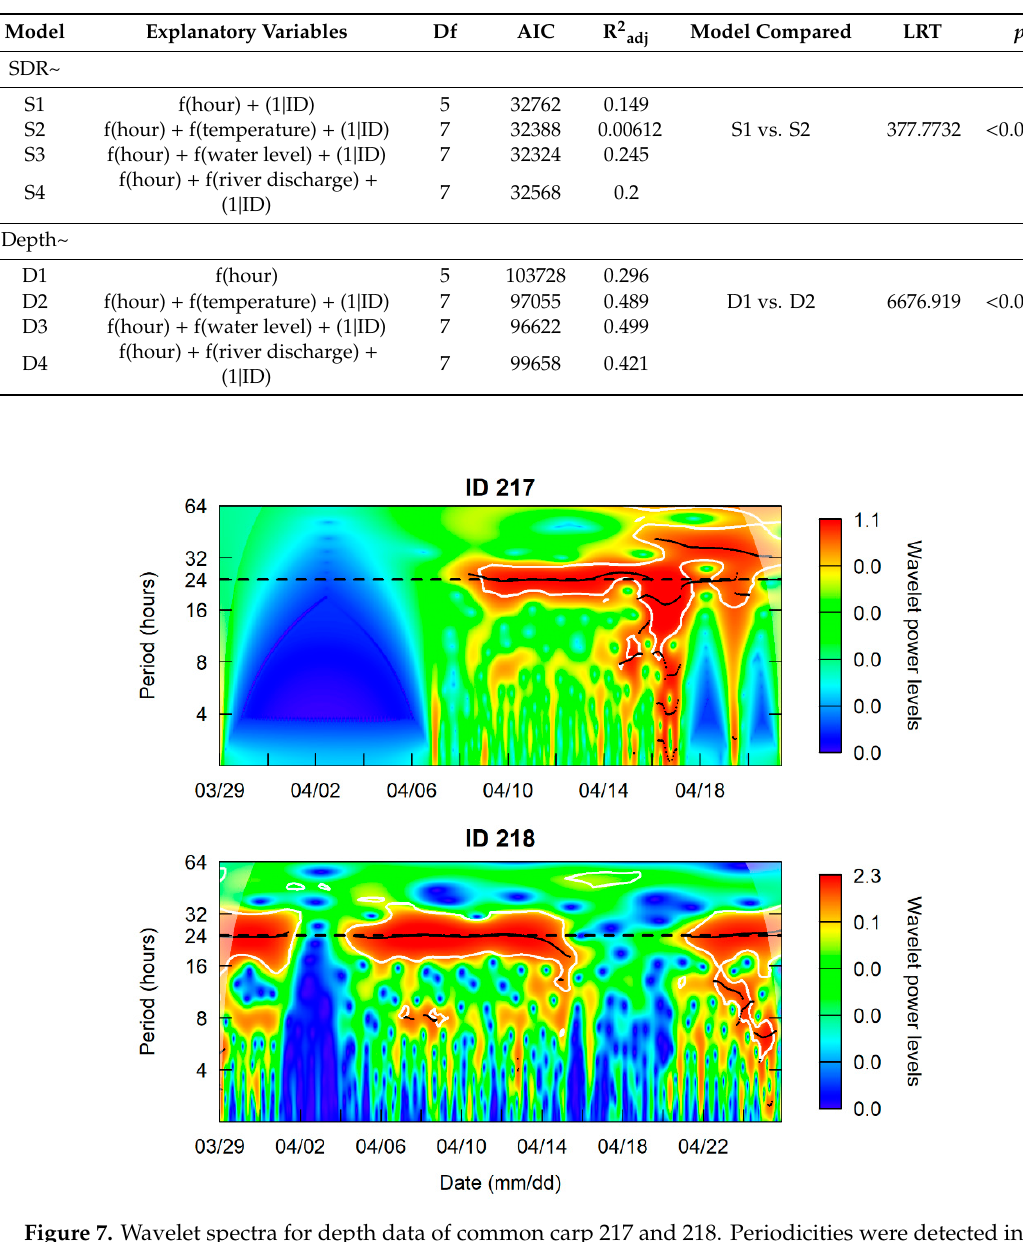
Table 5. General additive mixed models for the e ff ects of hour, water temperature, water level, and river discharge on the shortest distances to riverbanks (SDR) of common carp in the West River. An f indicates a smooth function. The random e ff ect of individual fish (ID) was included in all the models. R 2 adj represents the adjusted proportion of the variance explained by the model, and LRT represents the likelihood ratio test statistic.